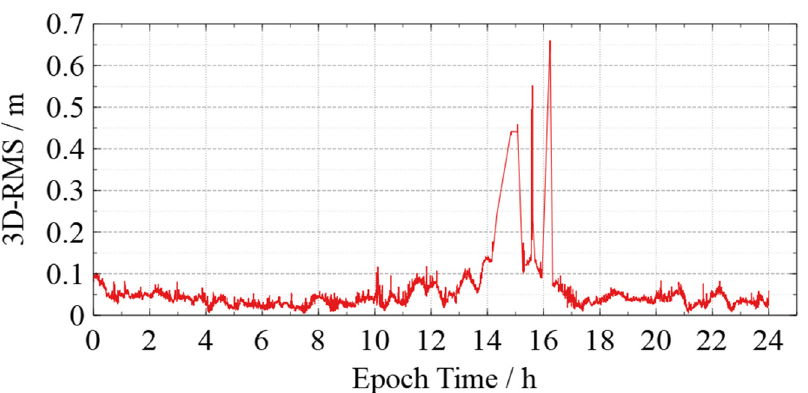
Figure 1. The 3-D RMS time series and jumping phenomenon in the kinematic orbit of Swarm-C occurred between 14:00 and 16:00 on DOY 162, 2021.